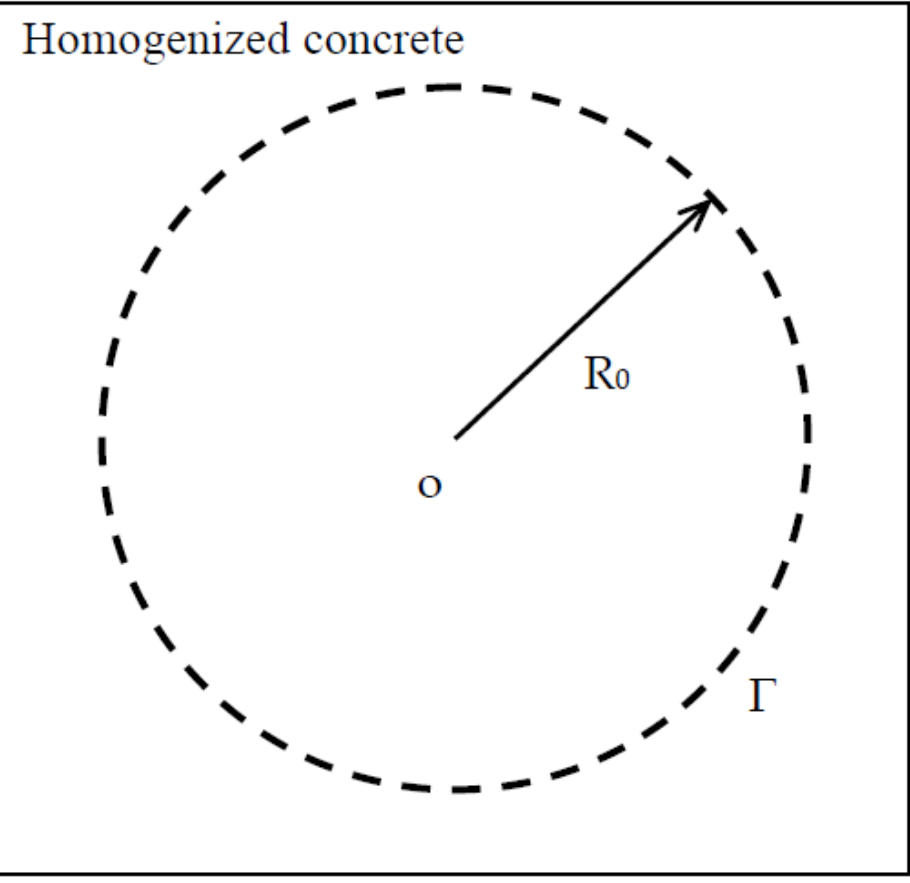
ff usivity D con